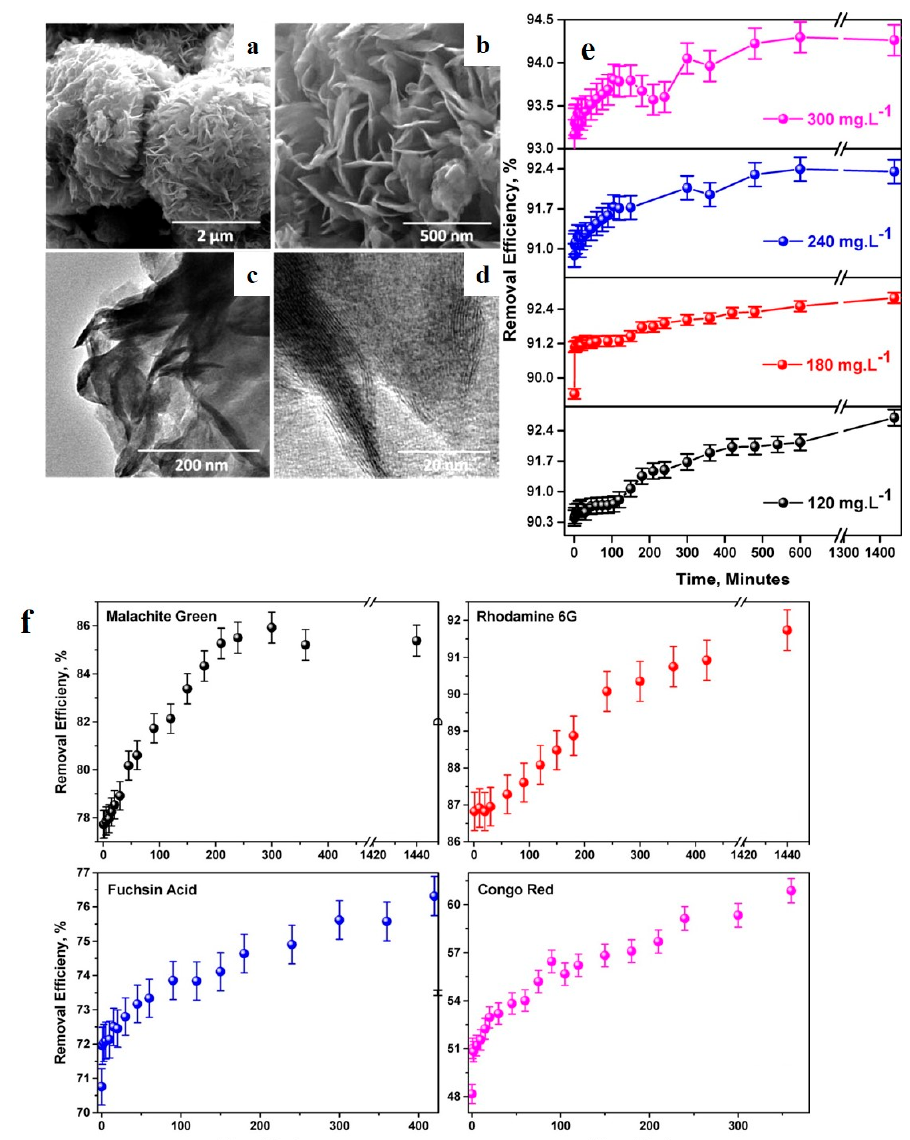
Figure 13. ( a and b ) FESEM and ( c and d ) HRTEM micrographs show the morphology and structure Figure 13. ( a , b ) FESEM and ( c , d ) HRTEM micrographs show the morphology and structure of the of the 3D MoS 2 flowers. ( e ) The time-dependent MB removal percentage at various MB 3D MoS 2 flowers. ( e ) The time-dependent MB removal percentage at various MB concentrations. ( f ) concentrations. ( f ) The time-dependent dye removal efficiency for the acidic and alkaline dye models. The time-dependent dye removal e ffi ciency for the acidic and alkaline dye models. Reproduced with Reproduced with permission [210]. Copyright 2016, American Chemical Society. permission [210]. Copyright 2016, American Chemical